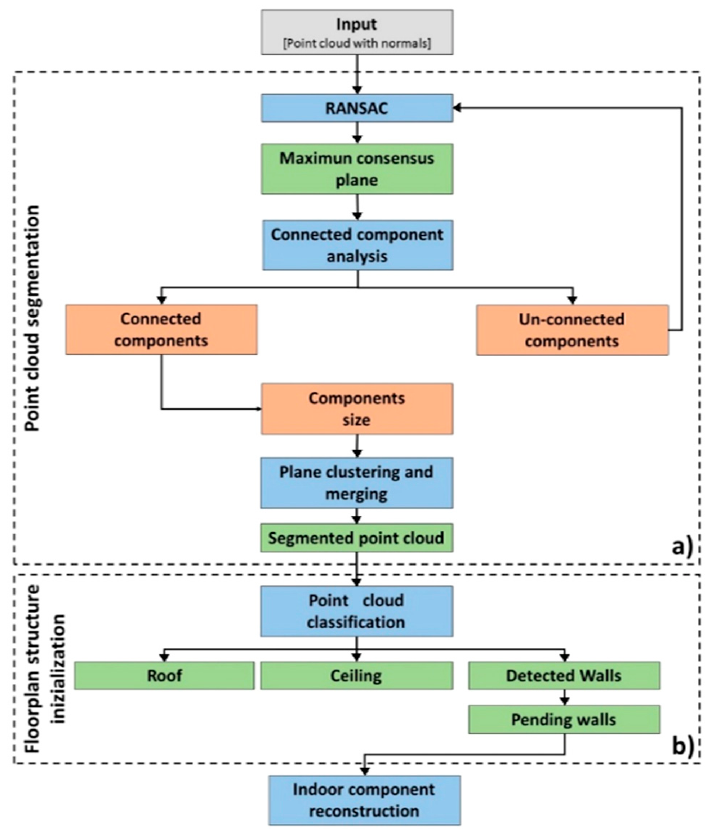
Figure 2. Workflow for planar primitive extraction: the two main steps are the segmentation of the point cloud using Random Sample Consensus (RANSAC) ( a ) and the semantic classification of detect surfaces into walls, floor, and ceiling ( b